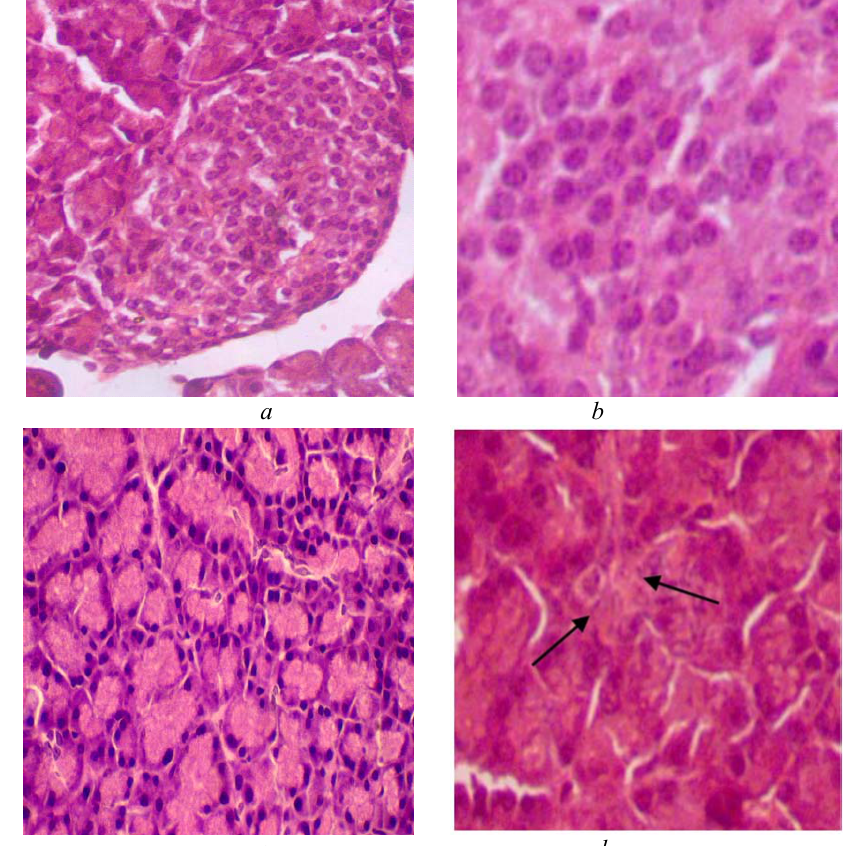
Fig. 4. The pancreas of Syrian hamsters receiving a dry extract of ginger on the background of a diet rich in fats and fructose: a – normal saturation, placement and differentiation of endocrinocytes in a pancreatic islet (×250); b – normal state of pancreatic β -cells ( х 400); c - the state of pancreatites corresponds to normal (×250); d – among acinus visible single actinost cells (×400).